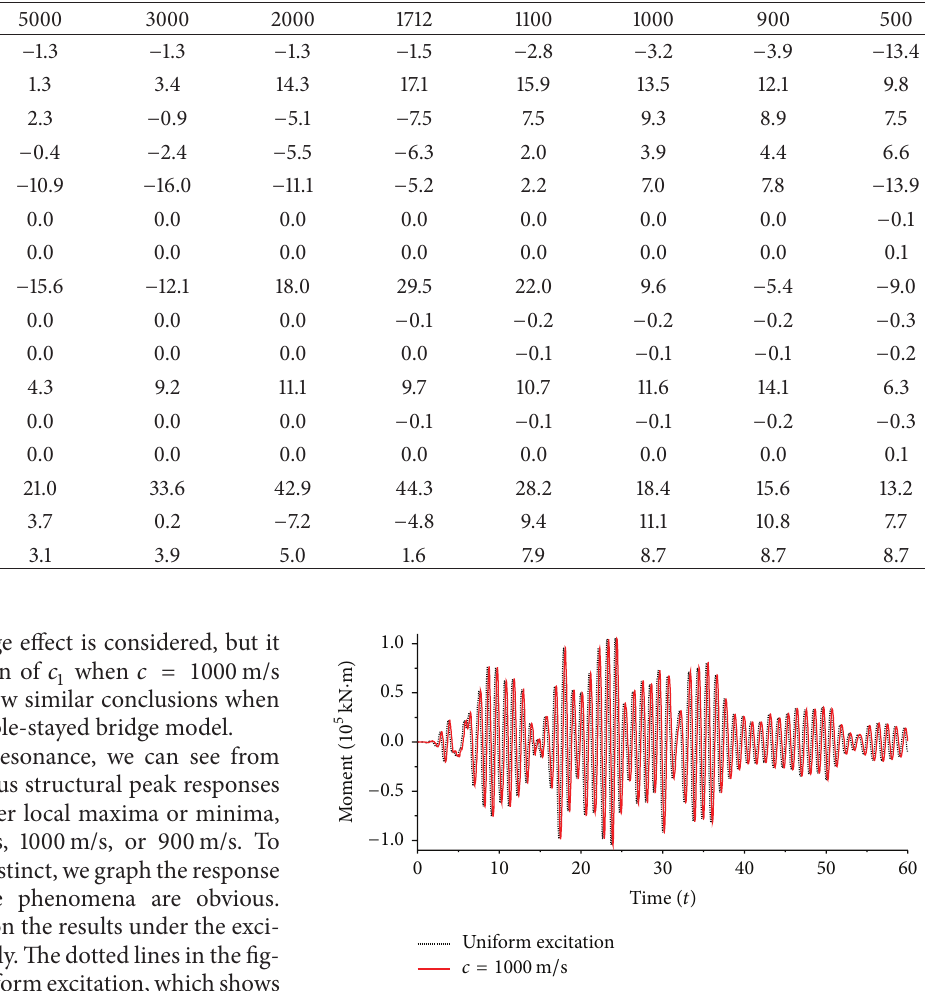
Figure 11: Time history of 𝑀 𝑃3 under the excitation of 𝑐 3